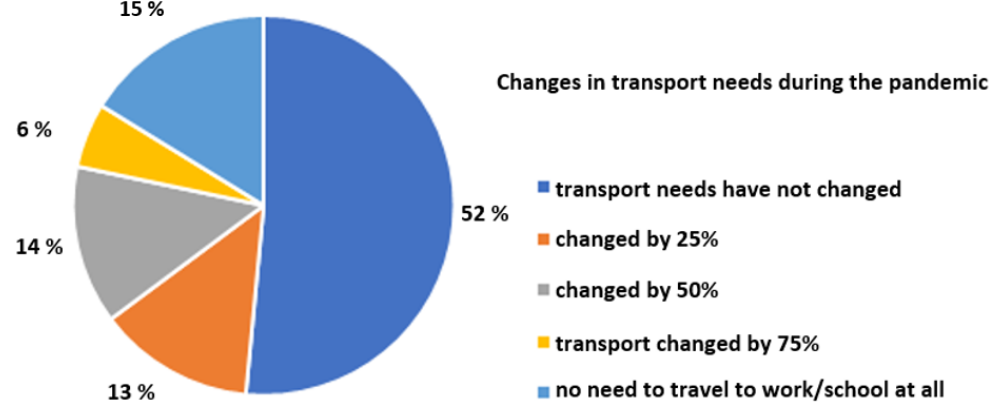
Figure 7. Share of travel before and during the COVID-19 pandemic. Source: based on [4]. It should be added that the reduction in public transport trips was caused not only on access to urban collective transport, resulting from the limit of seats occupied in vehi- cles.